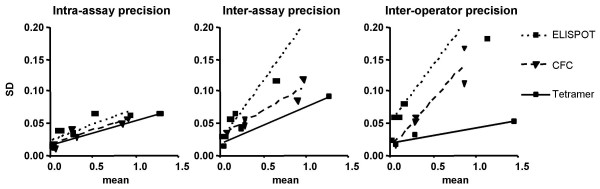
Comparison of precision across assays. ELISPOT means and SD for each sample were converted to percent of CD8+ T cells using the formula SFC/2.5 × 105/(CD8 percent of PBMC for that donor)×100. This allowed SD to be compared on the same scale. Note that the regression line for ELISPOT (dotted) is consistently higher than the regression line for CFC (dashed) or tetramer (solid). Due to complexity, data points for different donors and different antigens are not distinguished in this Figure; please refer to Figure 2 for relative responses of individual donors and antigens.